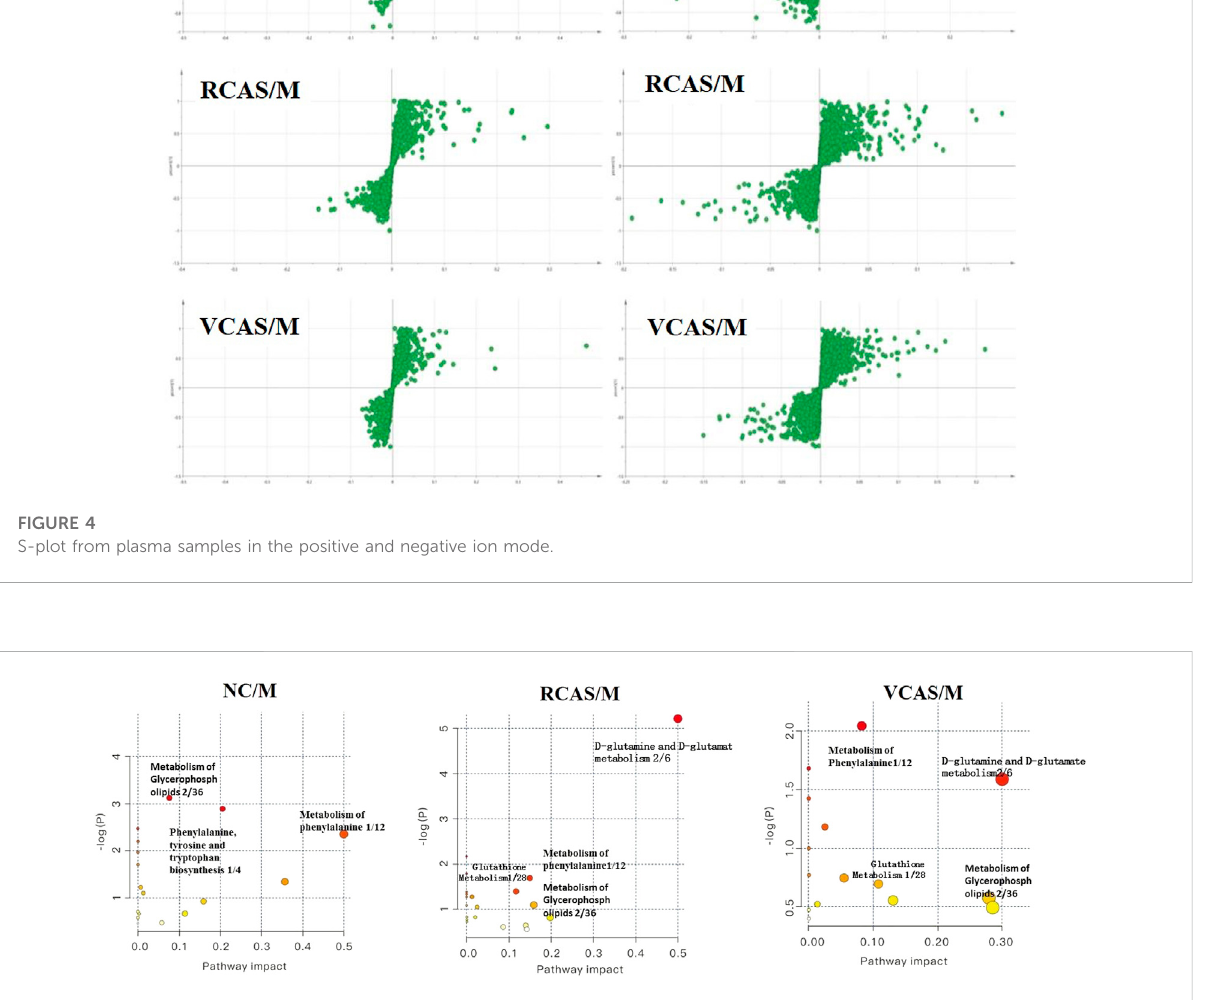
FIGURE 5 Enrichment results of metabolic pathways between plasma